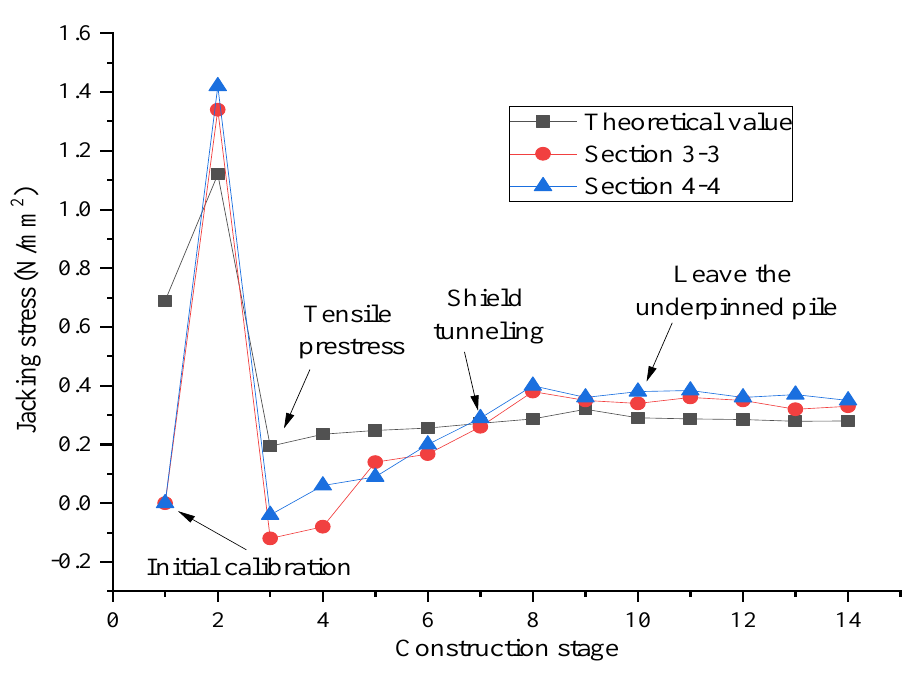
Measuring time Measuring section1 Measuring section2 Measuring section3 Measuring section4 Figure 14. Stress gauging result of piles foundation. In addition to test stress variation on the bridge pier, the underpinning bearing plat- form stress changes should also be monitored correspondingly to ensure the safety during shield tunnel construction. In this case, underpinning bearing platform stress sensors are placed in the top and bottom of the both sides numbered Sections 1.1–4-4. The underpinning bearing platform stress monitoring data from Sections 1.1 and 2.2 are presented in Figure 15. As the stress curves shows, stress on the top of the underpin- ning bearing platform reaches the maximum before the prestress system was established and the maximal principal stress is 1.41 MPa. When the steel strands are prestressed, un-